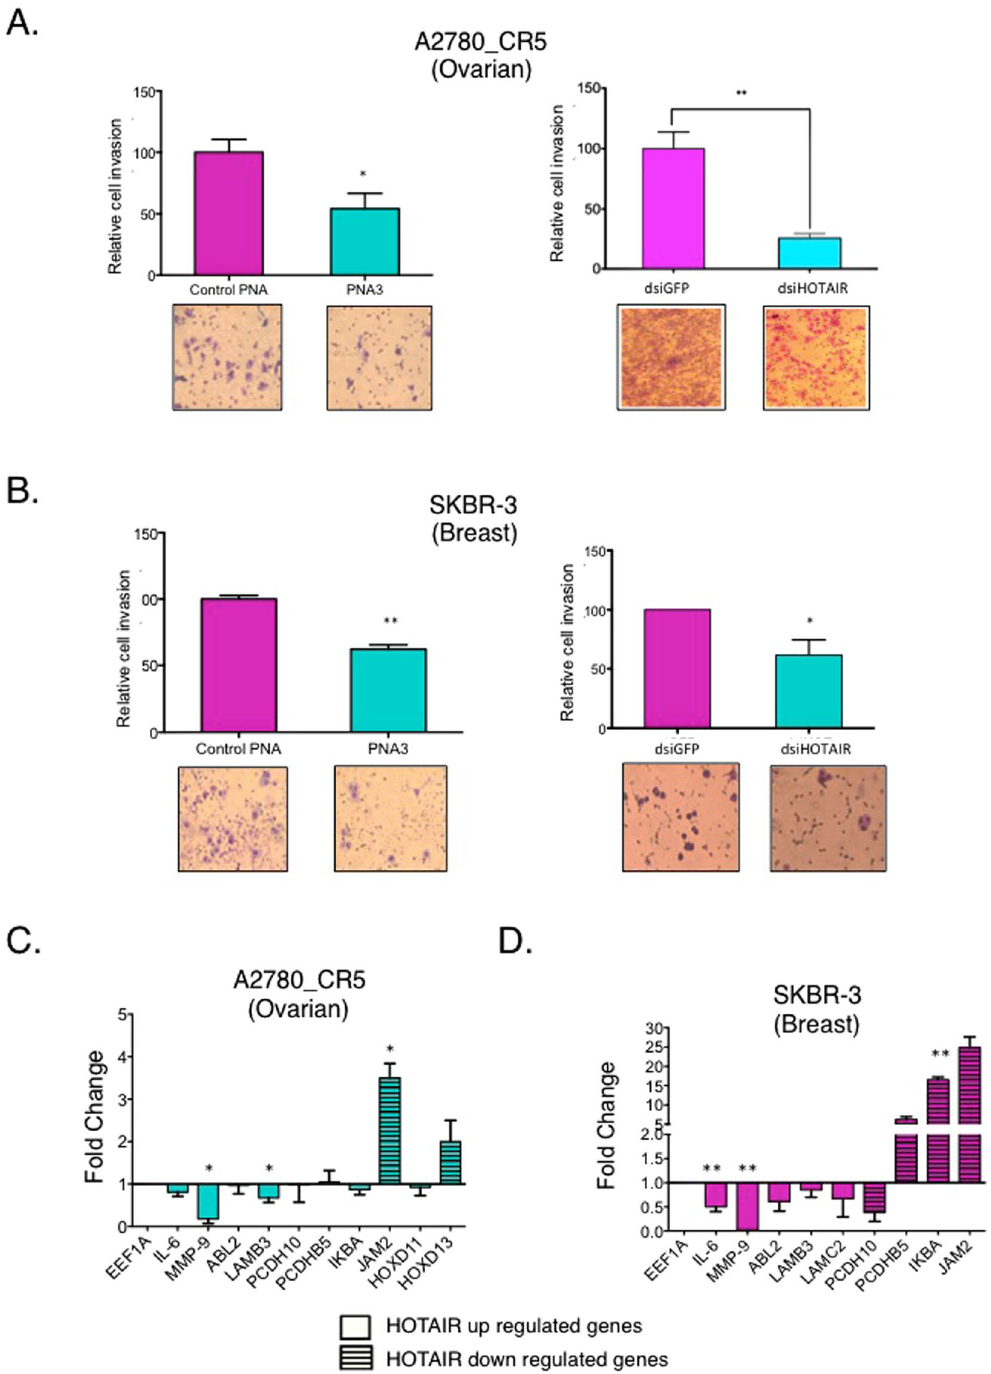
Figure 2. Combination treatment with CDDP and PNA3 reduces cell invasion, and HOTAIR target gene expression in breast and ovarian cancer cells. ( A ) A2780_CR5 or ( B ) SKBR-3 cells were treated with either PNA3 or control PNA (1 μ M) or transfected with either dsiGFP or dsiHOTAIR for 24 hrs and invasion assays were performed. Representative images of invading cells were counted under a light microscope (20X magnification) and normalized to control ( C ) A2780_CR5 and ( D ) SKBR3 cells were treated with either PNA3 or control PNA (1 μ M) for 48 hrs and qPCR was performed for HOTAIR targets: IL-6, MMP-9, ABL-2, LAMB3, LAMC2, PCDH10, PCDHB5, IKBA, JAM2, and HOXD13. Genes were omitted from certain cell lines due to undetectable endogenous expression. Asterisks indicate P < 0.05 ( * ) or P < 0.01 ( **